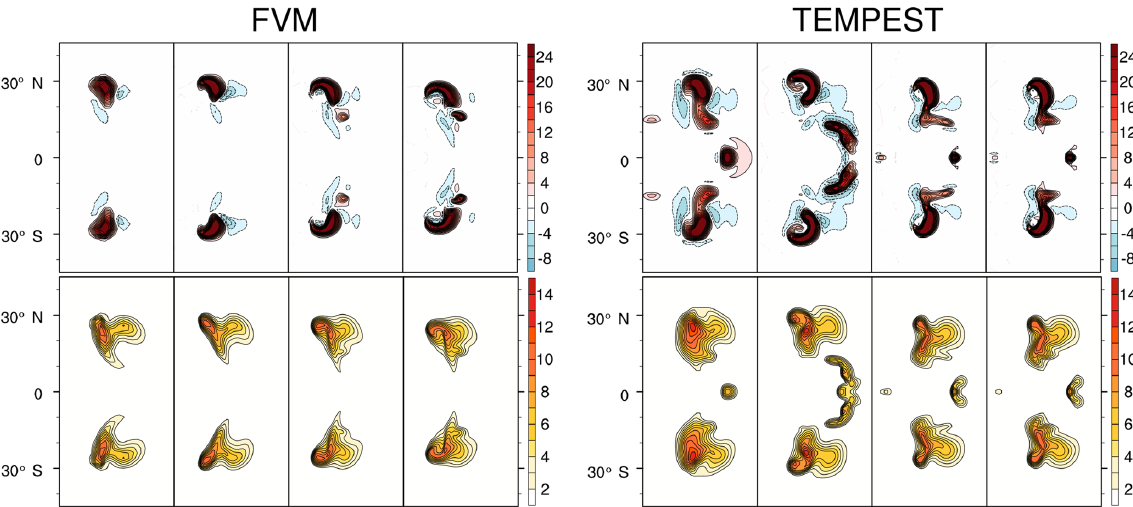
Figure 8. As in Fig. 4 except showing the subset of models that completed a 0.25km test. From left to right, nominal model resolutions are 2, 1, 0.5, and